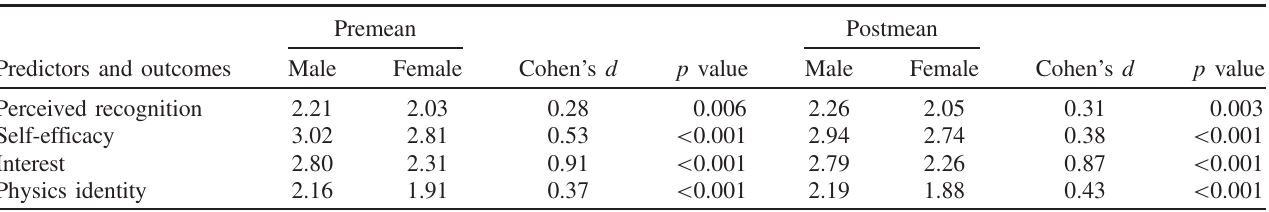
TABLE VII. Mean physics 2 pre and postpredictor and outcome values by gender as well as statistical significance ( p values) and effect sizes (Cohen ’ s d) by gender for 274 women and 148 men. All p values < 0 . 001 .